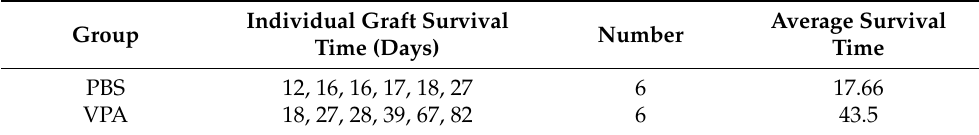
Table 2. The survival time of allogeneic islet graft in the C57BL/6 recipients.